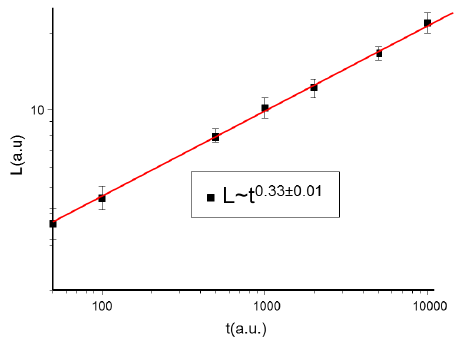
Figure 2: Size of the domains L vs. time t . The results show a growth law L ∼ t 0 . 33 ± 0 . 01 in good agreement with the previous results. The plotted values corre- spond to an average over 10 simulations.